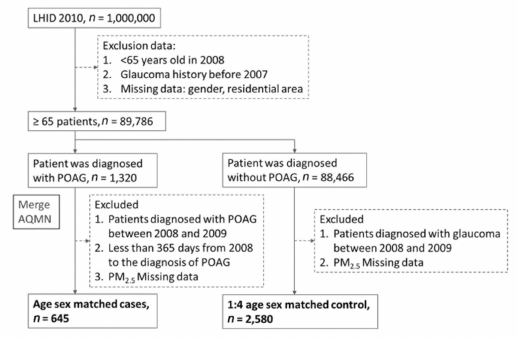
Figure 1. Flowchart of this study